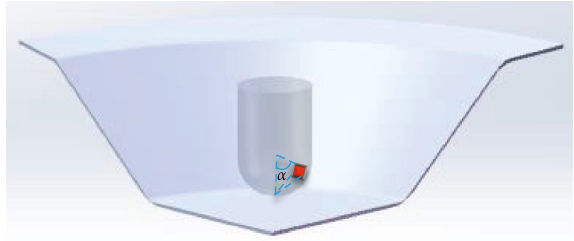
Figure 2: Schematic diagram of the 3D model of single point incremental forming.